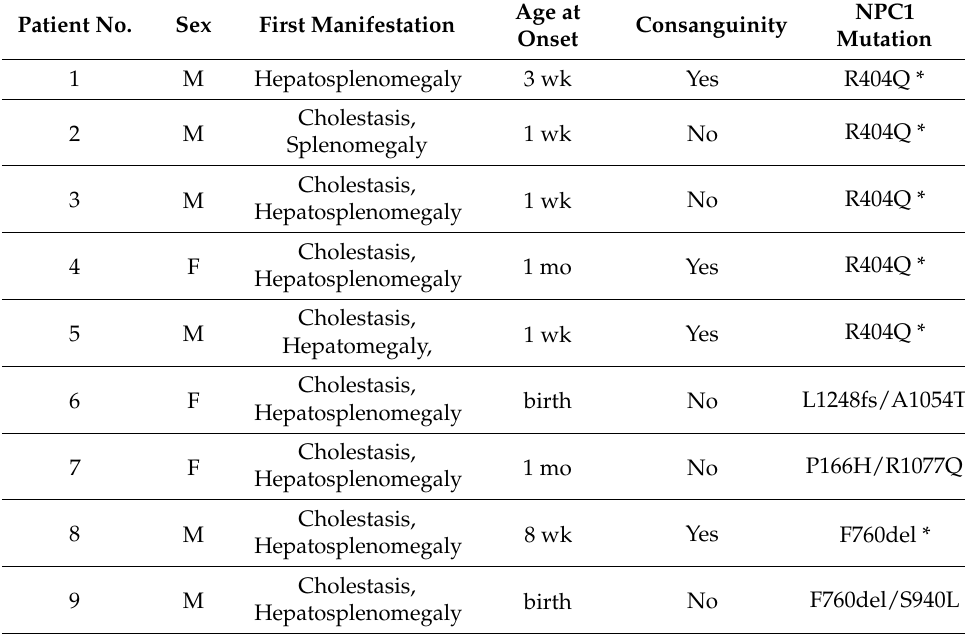
Table 1. Clinical and genetic characteristics of 9 patients with NPC.